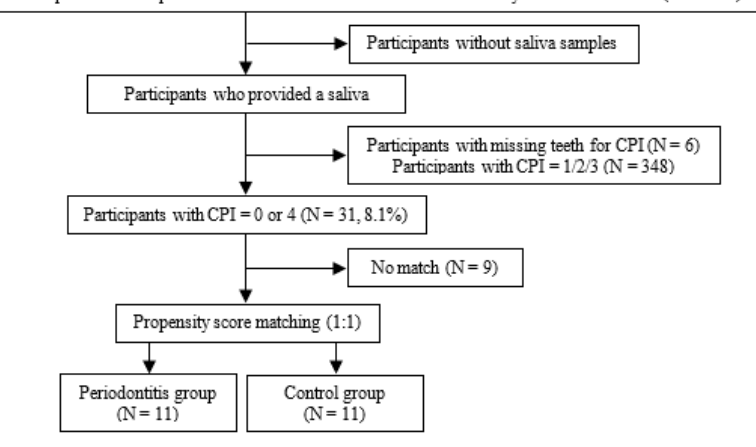
Figure 1. Study flowchart. CPI, community periodontal index. Table 1. Differences in parameters between the periodontal disease and control groups.